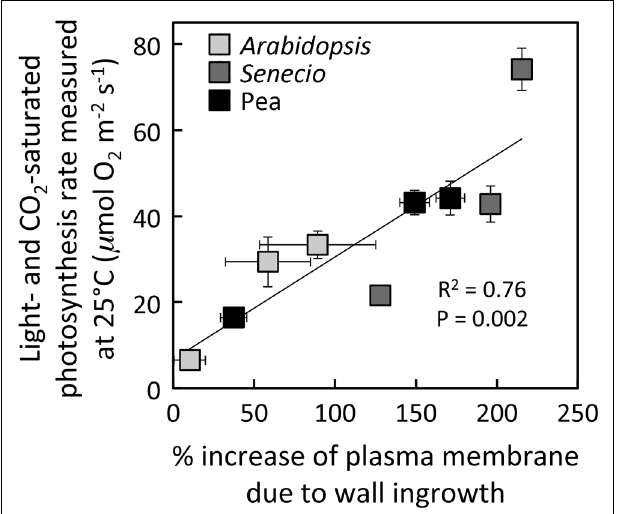
FIGURE 2 | Relationship between the percent increase of transfer-cell plasma membrane length in foliar minor veins and photosynthetic capacity from leaves of A. thaliana (light gray), pea (black), and S. vulgaris (dark gray) developed under LL or HL, or seven days after transfer of leaves developed under LL to HL. For S. vulgaris , the values for percent increase in transfer-cell plasma membrane length are averages of the mean values obtained from PCs and CCs. For additional information, see Figure 1